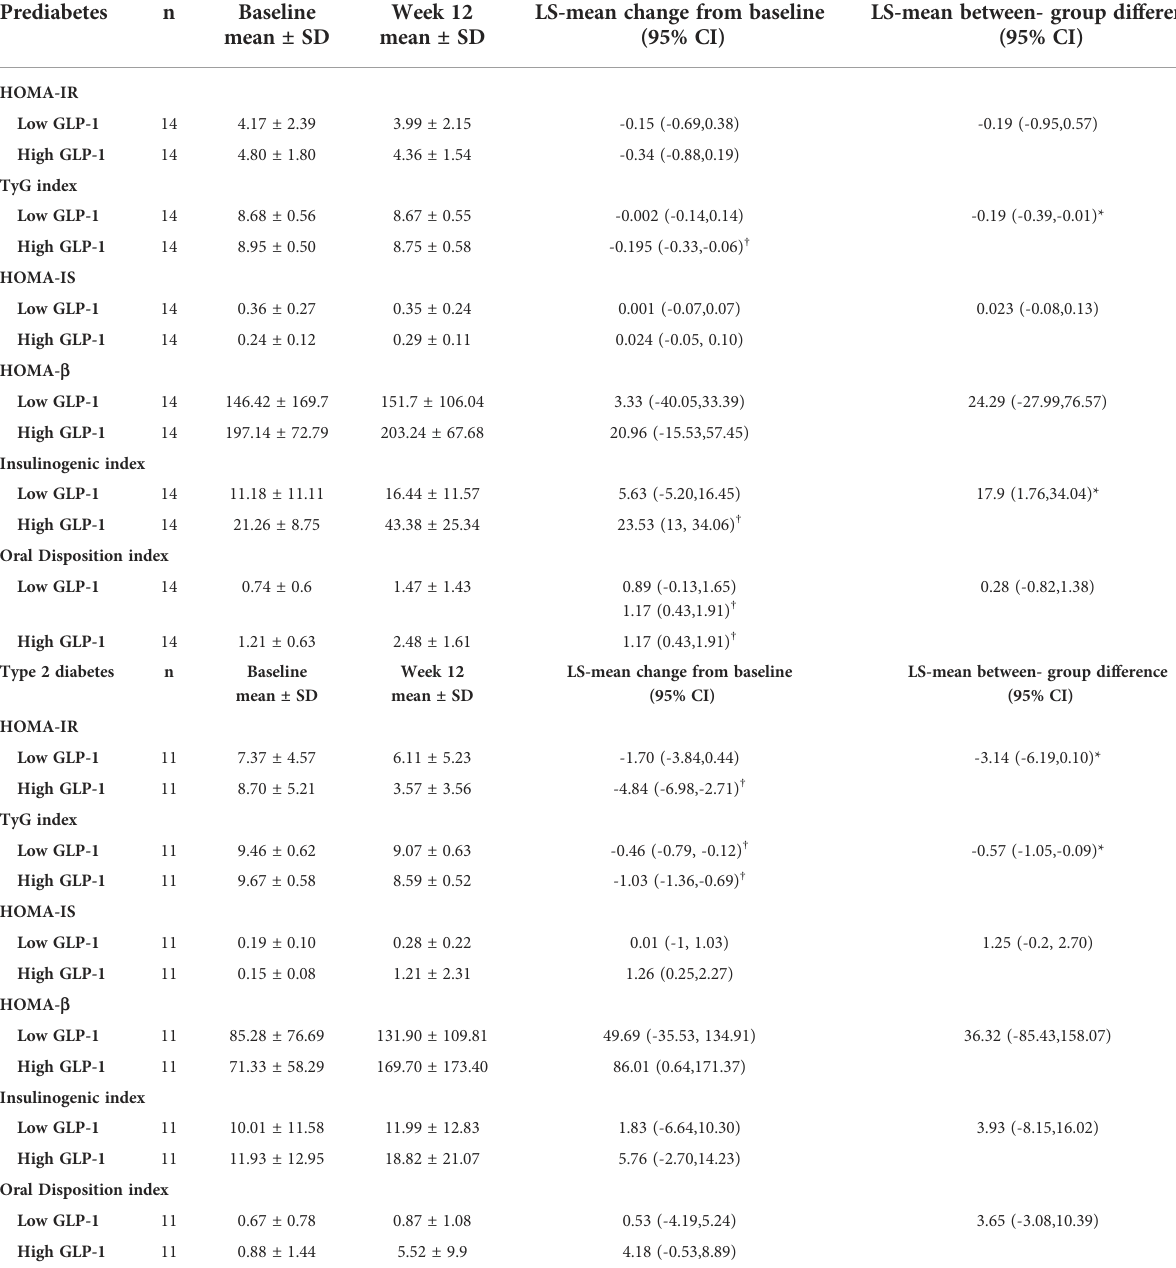
TABLE 4 Change from baseline in indices of insulin resistance and beta cell function in subjects with prediabetes and type 2 diabetes.